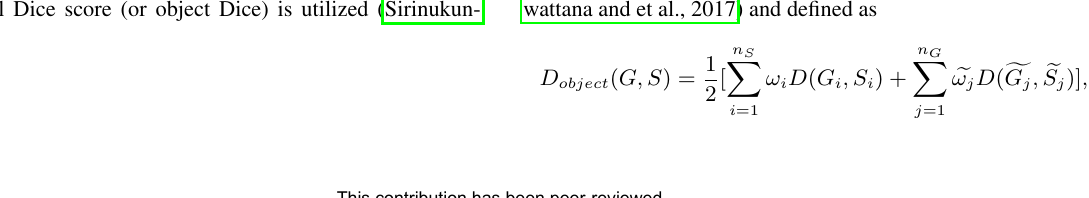
Figure 7. Results of the proposed CNN for PATH-DT-MSU dataset if trained with normal gland annotations only; (a) is ground truth segmentation, (b) is the predicted